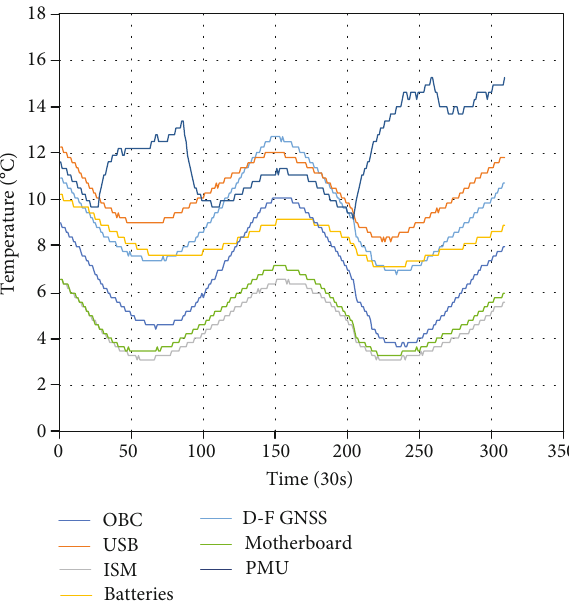
Figure 18: Temperatures of devices inside Q-SAT on